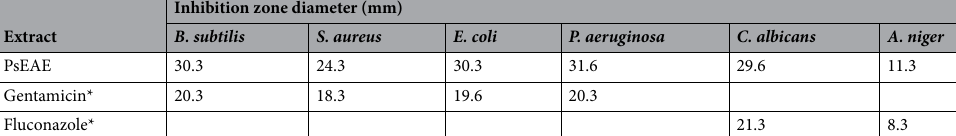
Table 4. Antimicrobial activity of ethyl acetate crude extract of endophytic fungus Paecilomyces sp. (AUMC 15510) isolated from stem of C. monacantha in the agar diffusion assay. PsEAE—ethyl acetate crude extract obtained from the culture filtrate of Paecilomyces sp. in PDB medium. Experiments were done in triplicates. Standard deviation value is ± 0.58 for all tested pathogens and control. *Gentamicin and fluconazole were used as a positive